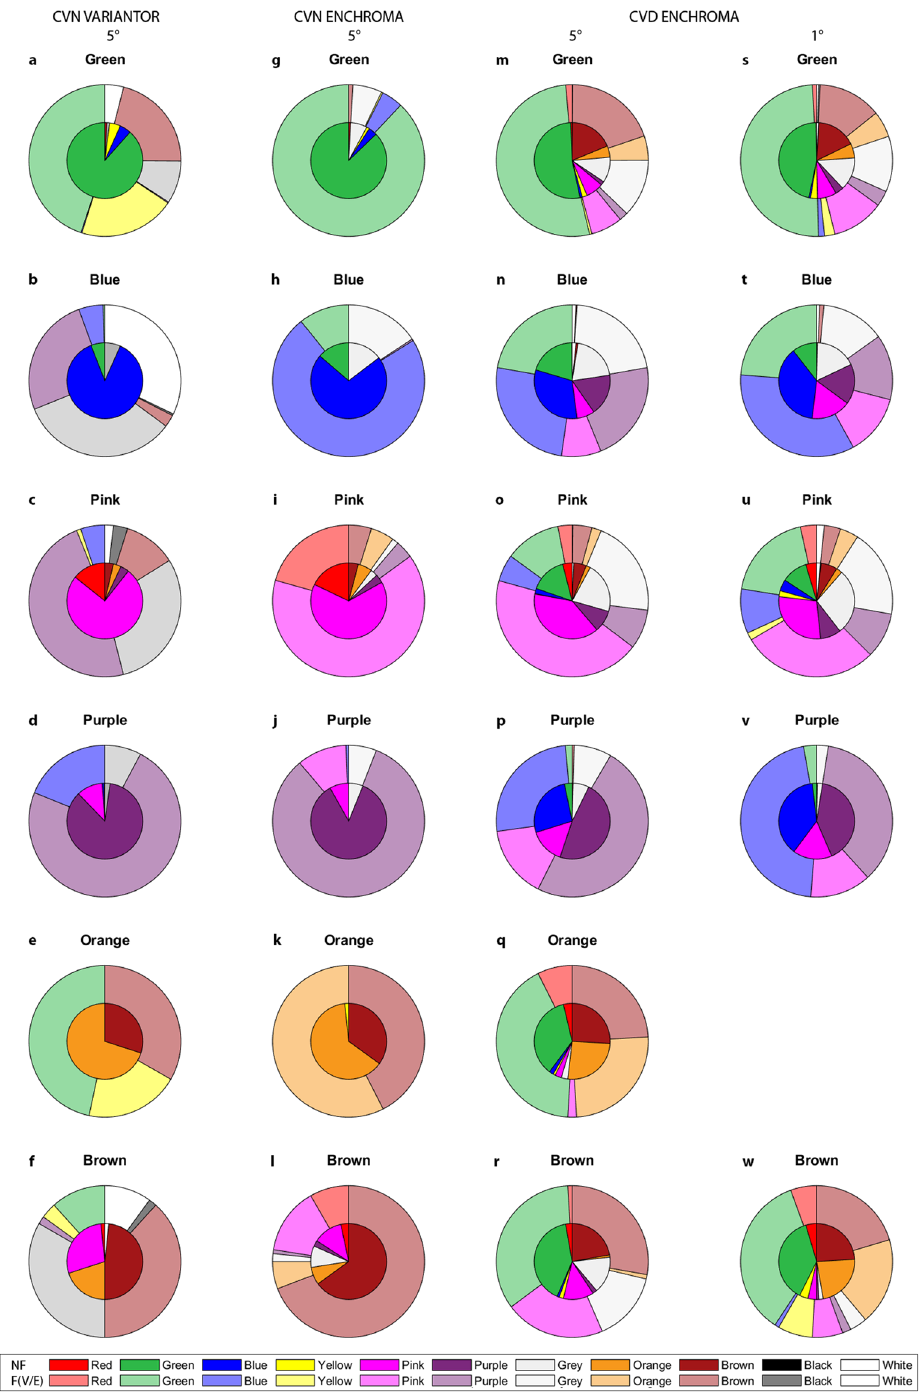
Figure 4. Pie pictorials for naming results of British participants using CVA-UMinho task, with and without filters. Naming task percentages for the modal criterion for CVN-Variantor ( a – f ), CVN-EnChroma ( g – l ) and CVD-EnChroma of the British sample with 5° stimuli ( m – r ) and CVD-EnChroma with 1° stimuli ( s – w ). Inner pies (solid colours) show naming proportions without filters and outer doughnuts (translucent colours) show them with filters. Notes: In colour key, NF stands for non-filter condition and F(V/E) stands for filter (Variantor/EnChroma) conditions. Percentages represented can be found in Supplementary Tables S3, S5, S9 and S11. Equivalent graphs for the Portuguese sample can be found in Supplementary Fig. S1. For example, hit-rate (i.e. 88% without and 45% with Variantor for Green in panel ( a ); 87% without and 5% with Variantor for Blue in panel ( b ); error-rate (i.e. 5% without and 20% with Variantor for Yellow, as Green in panel ( a ) appear in Supplementary Table S3. Pie chart colours are approximations of best exemplars of each basic colour term